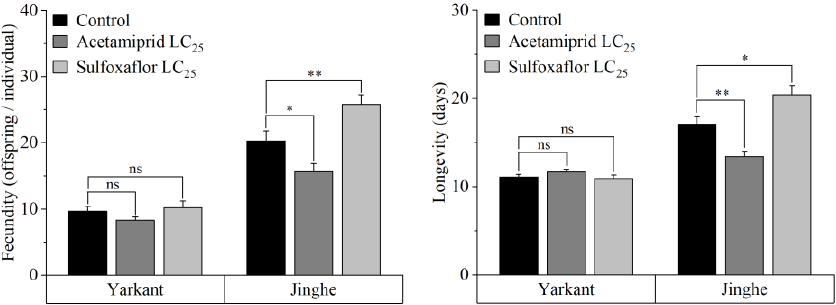
Figure 1. Effects of sublethal concentrations of acetamiprid and sulfoxaflor on the fecundity and longevity of the F 0 generation in Yarkant and Jinghe. The data are represented as mean ± SE. Asterisks above the bars correspond to significant differences between the treatment and the control based on Student’s t -tests (*, p < 0.05; **, p < 0.01).